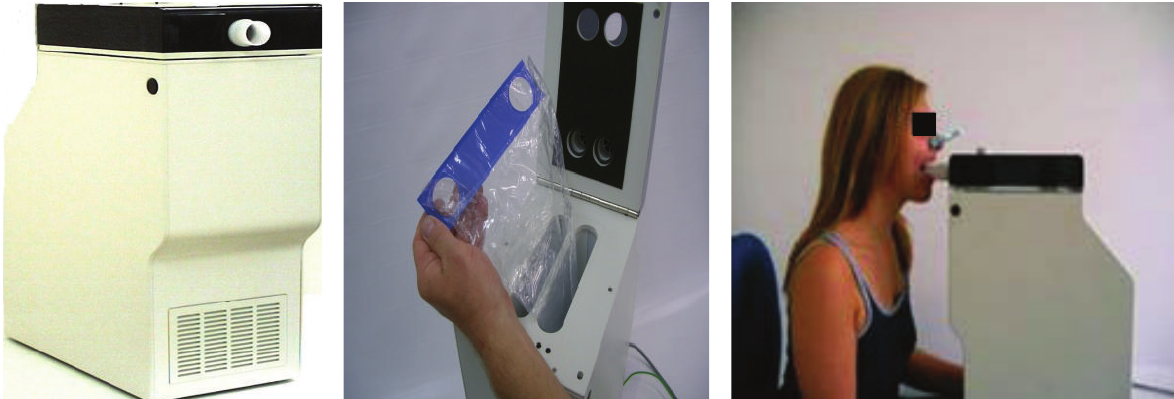
Figure 1: EcoScreen 2 device for exhaled breath condensate (EBC) collection (FILT Lungen-& Thorax Diagnostik GmbH). EcoScreen 2 electrically refrigerates exhaled air, conducted through a lamellar PFTE coated aluminum double lumen system. EBC is formatted in a disposable polyethylene bag (at approximately − 10 ∘ C). It also allows the fractionated collection of EBC from different areas of the bronchial tree into two disposable polyethylene bags, so that the dead space condensate which contains biomarkers of no clinical relevance can be discarded. The device is not portable and weighs 20 kg ( published with permission from FILT Lungen-& Thorax Diagnostik GmbH